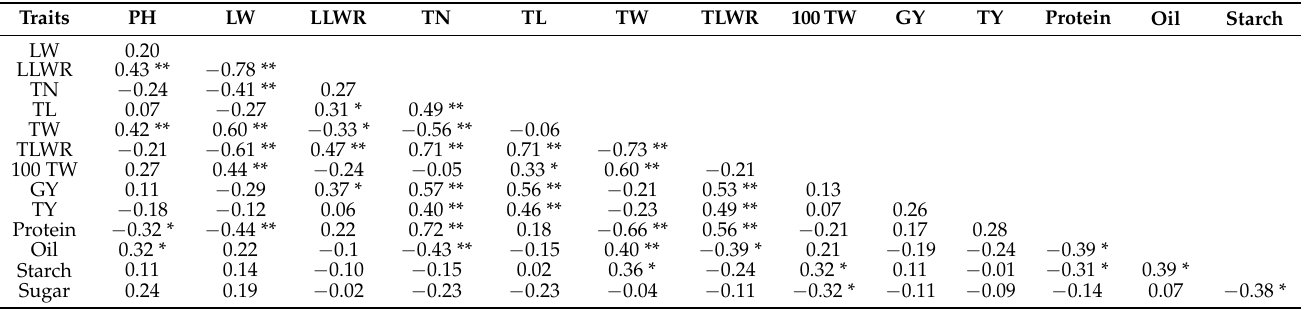
Table 4. Correlation coefficients of 14 agronomic and biochemical traits among 42